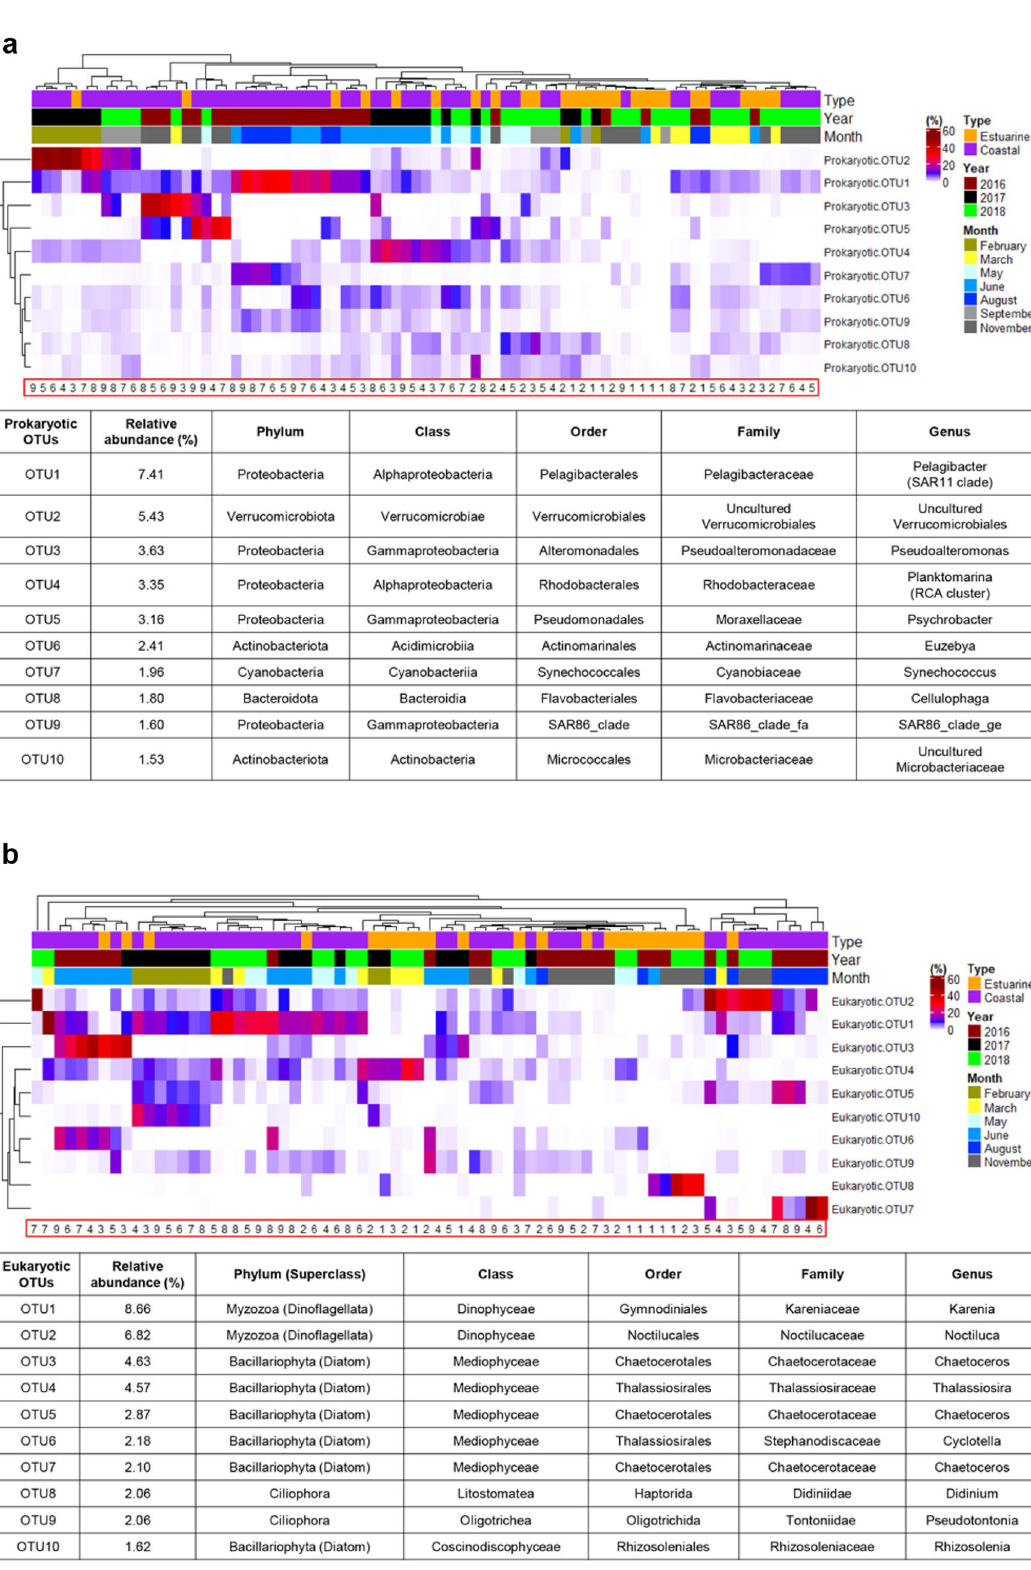
Figure 5. Heat-map visualization for distribution of microbial operational taxonomic units (OTUs). ( a ) Prokaryotic OTUs and ( b ) eukaryotic OTUs. Numbers in red line box indicate the GB